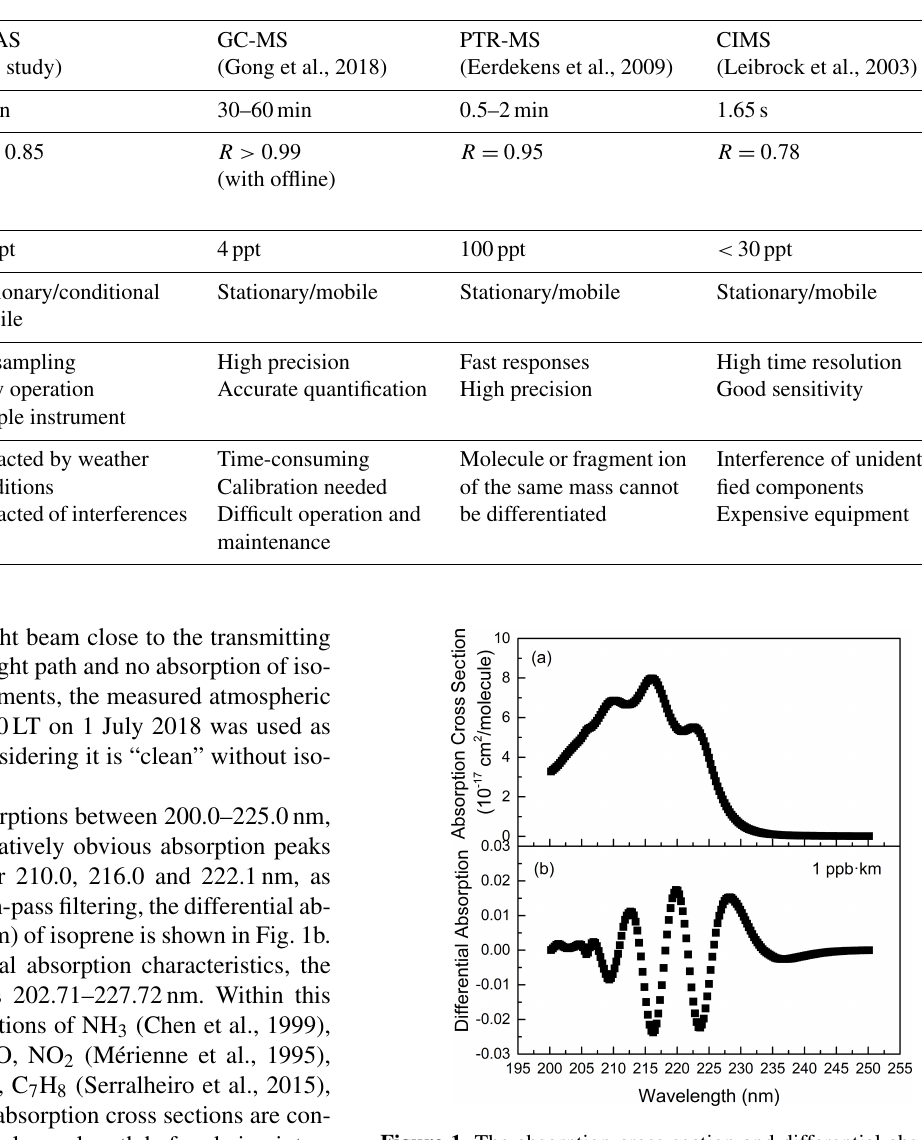
Figure 1. The absorption cross section and differential absorption spectrum of isoprene in